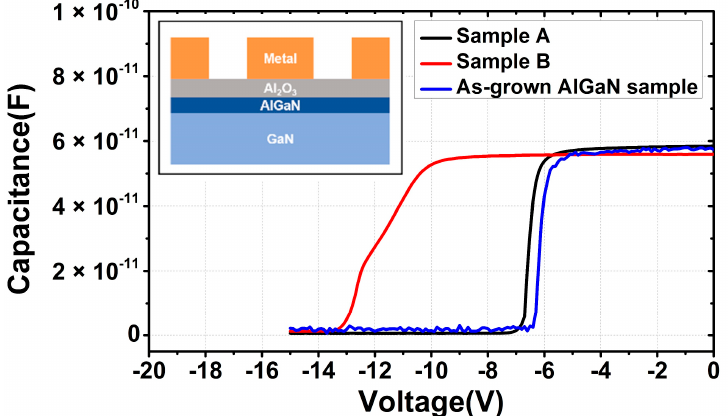
Figure 7. C–V characteristics of Ni/Al 2 O 3 /AlGaN MIS capacitors with selective and nonselective p -GaN etching. Additionally, as-grown AlGaN sample is referenced here.